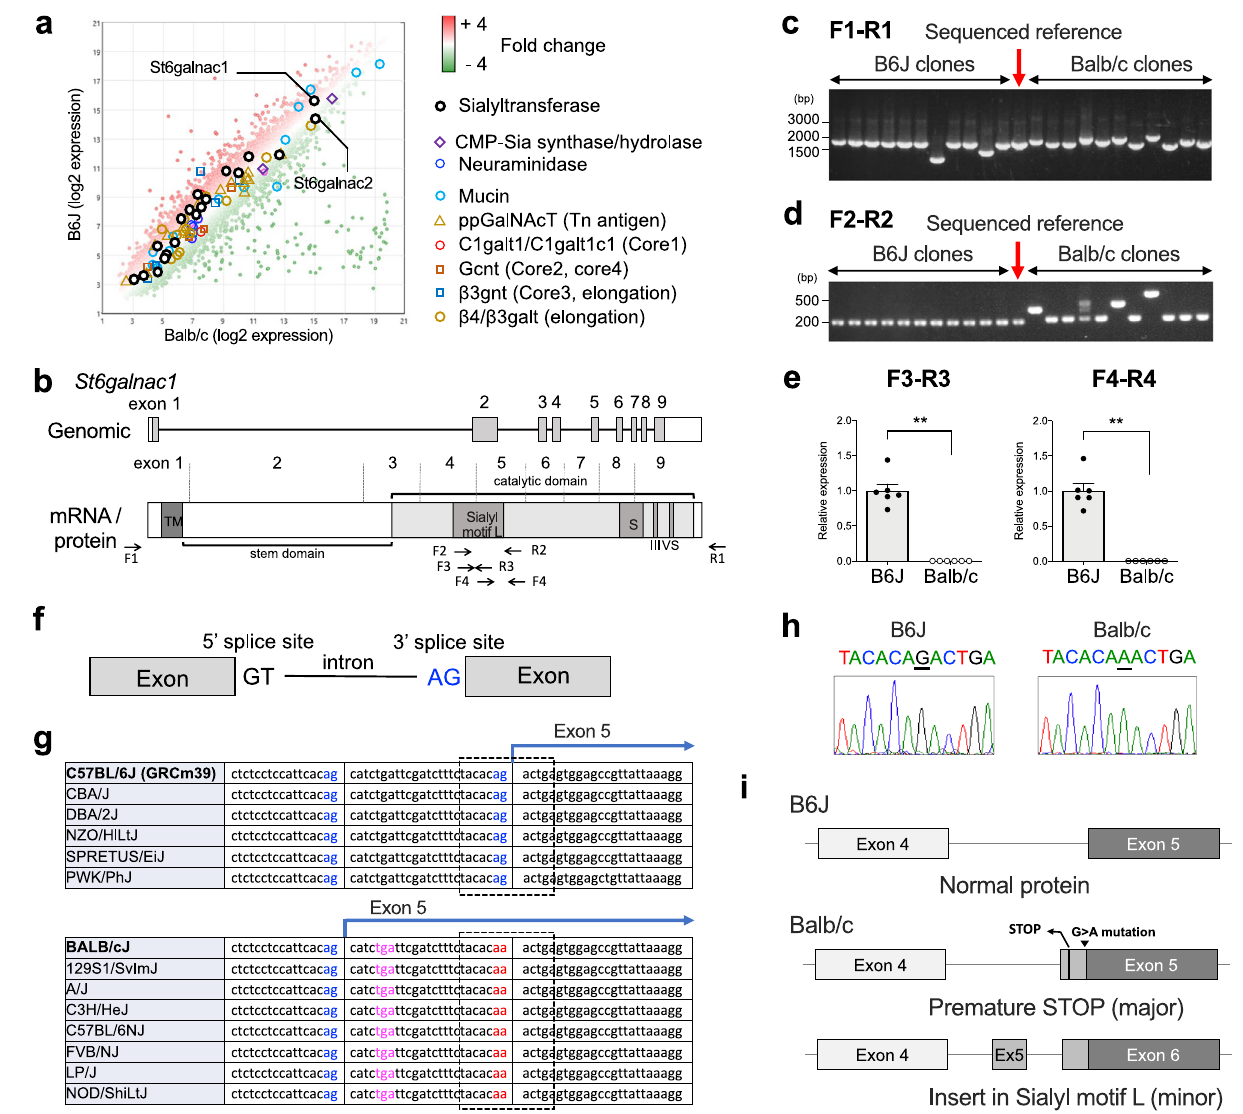
e Quantitative PCR for intact sialyl motif L. n =6 for each strain. ** p <0.01 ( p =0.0022 for F3-R3 and p =0.0022 for F4-R4) by two-tailed Mann – Whitney test. Data represents mean±S.E.M. Data are representative of two independent experiments. f Schematicrepresentationofsplicingsites. g Straincomparisonof3 ʹ splice site sequencesavailableatEnsembl database 52 . Blue, potential 3 ʹ splicesites; Red, disabled 3 ʹ splice site; Magenta, premature stop codon. The range of Sanger sequencing shown in ( h ) is circled with a dotted line. h Sanger sequencing of 3 ʹ splice site of intron before exon 5. i Schematic representation of exon usages of cloned St6galnac1 . Source data are provided as a Source Data fi le ( c , d , e